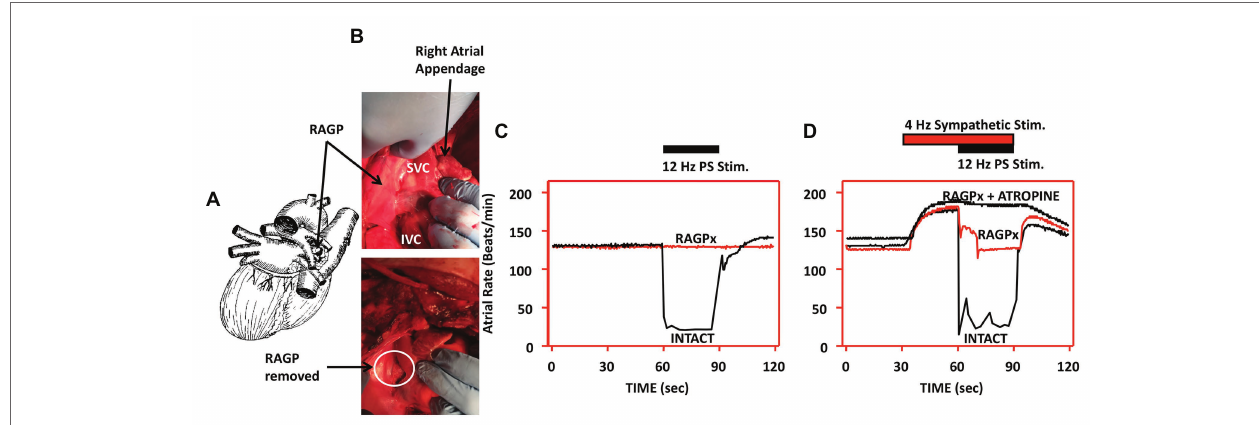
FIGURE 5 | Interactions between sympathetic and parasympathetic system occur at end-effector as well as within the ICNS. Disruption of the RAGP alters neural control of heart rate. (A) Diagram depicting location of RAGP, posterior to the caval veins and anterior to right pulmonary artery and right superior pulmonary vein. (B) Photographs of RAGP before and after ablation. (C) Evoked bradycardia with 12 Hz parasympathetic stimulation in intact state, with loss of evoked bradycardia after RAGP ablation. (D) Combined sympathetic (4 Hz) and parasympathetic (12 Hz) stimulation in intact state, following RAGP ablation, and RAGP ablation with atropine administration. Adapted from McGuirt et al.